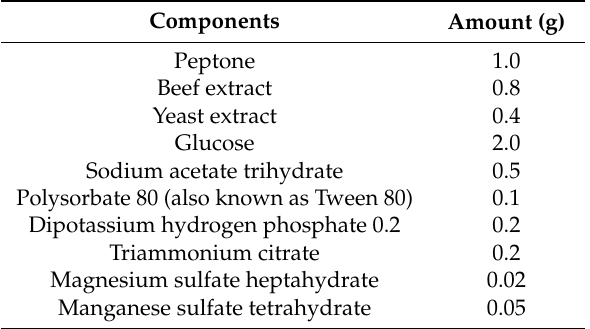
Table 2. Man Rogosa and Sharpe (MRS) composition in 100 mL